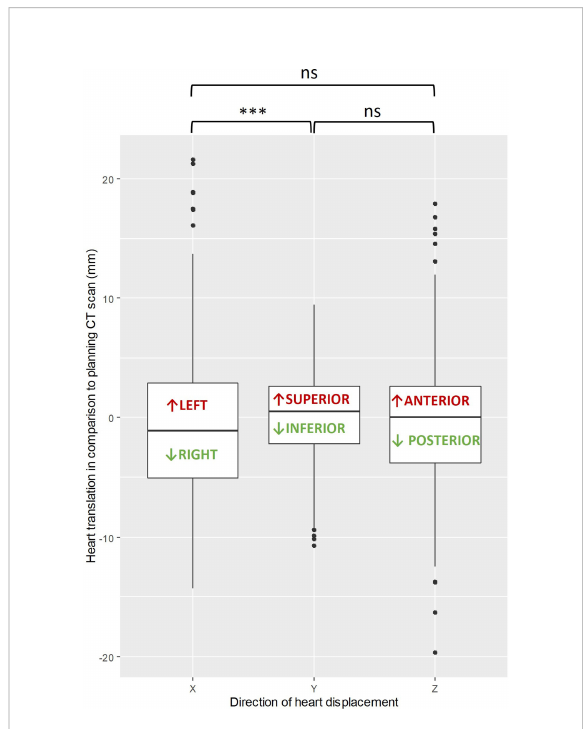
FIGURE 3 Box plot showing the differences in median heart translation (mm) in each axis (X, Y, Z), with the Wilcoxon rank-sum test comparison (black bracket). ***: p-value is less than 0.001, ns: not signi fi